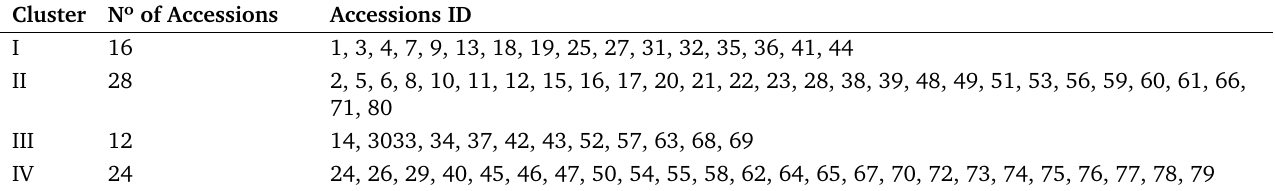
Table 6. Distribution of 80 Stylosanthes scabra Vogel accessions in four clusters based on the forage quality variables. Embrapa Cerrados, Planaltina, DF, 2020.